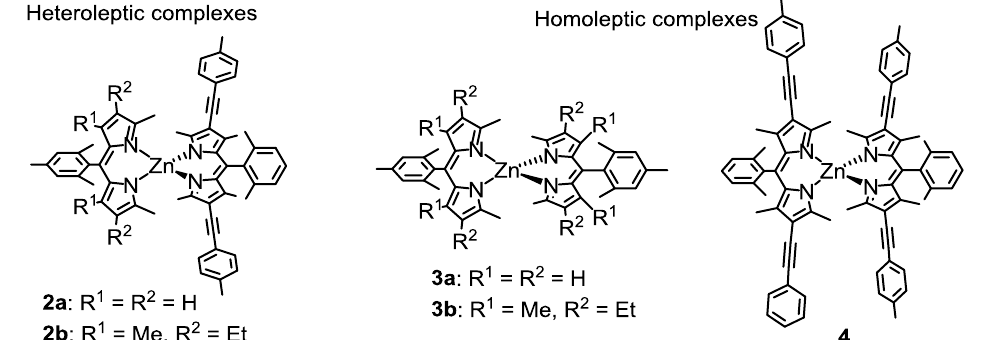
Figure 16. Homoleptic bis(dipyrrinato)zinc(II) complexes 2a and 2b , and corresponding homoleptic complexes 3a , 3b , and 4